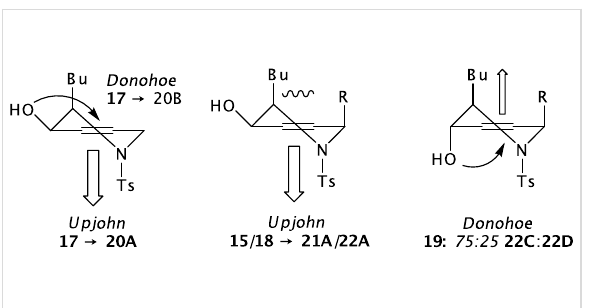
Figure 4: Diagnostic nOe observations for the piperidine 22A